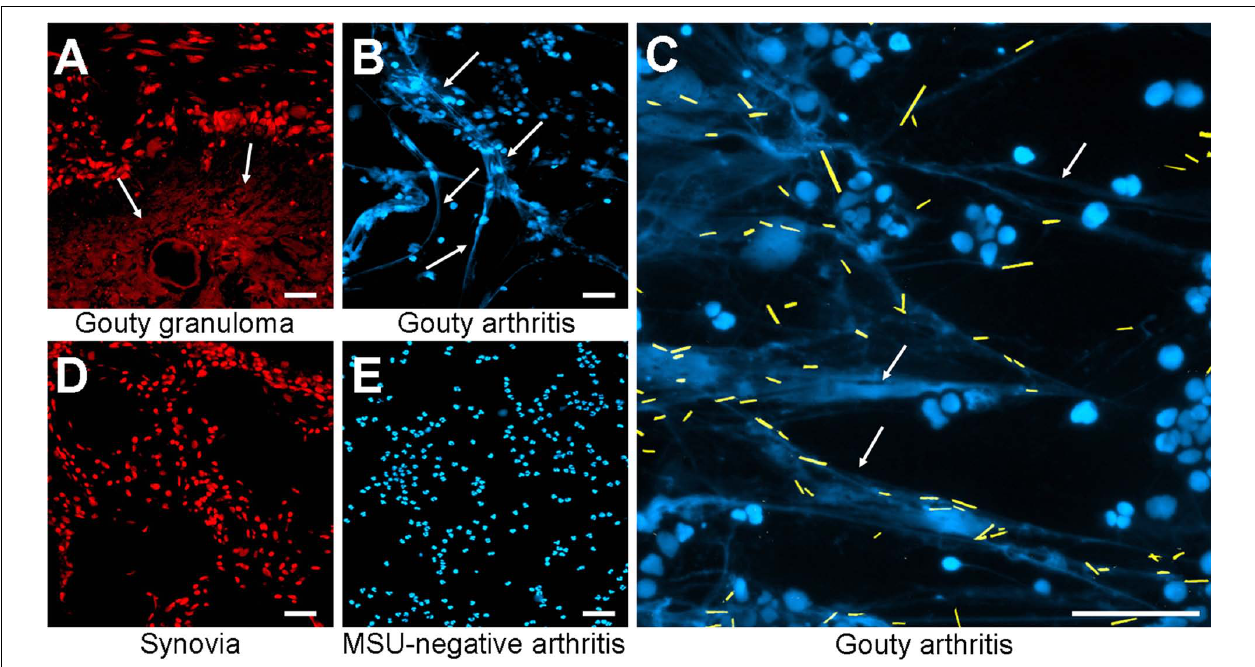
FIGURE 2 | Patients with MSU-induced inflammation display extranuclear DNA in tissue sections. Revealed by DNA staining with propidium iodide, sections of gouty granulomas (A) display extranuclear DNA (arrows). Synovial fluids of patients suffering from gouty arthritis display extranuclear DNA (arrows) visualized by staining with DAPI (B,C) . All